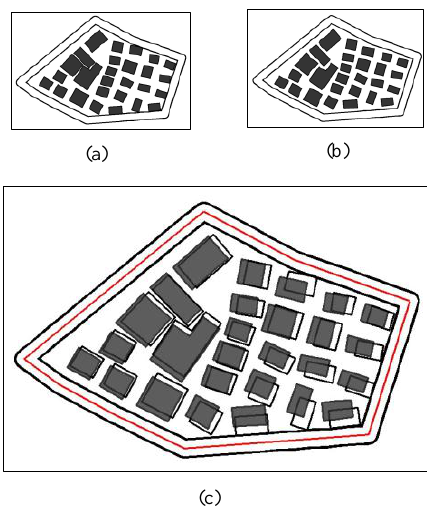
Figure 6. Result of displacement: (a) Initial buildings (1:10k), (b) Displaced buildings (1:10k), and (c) Comparing the Initial and final state.